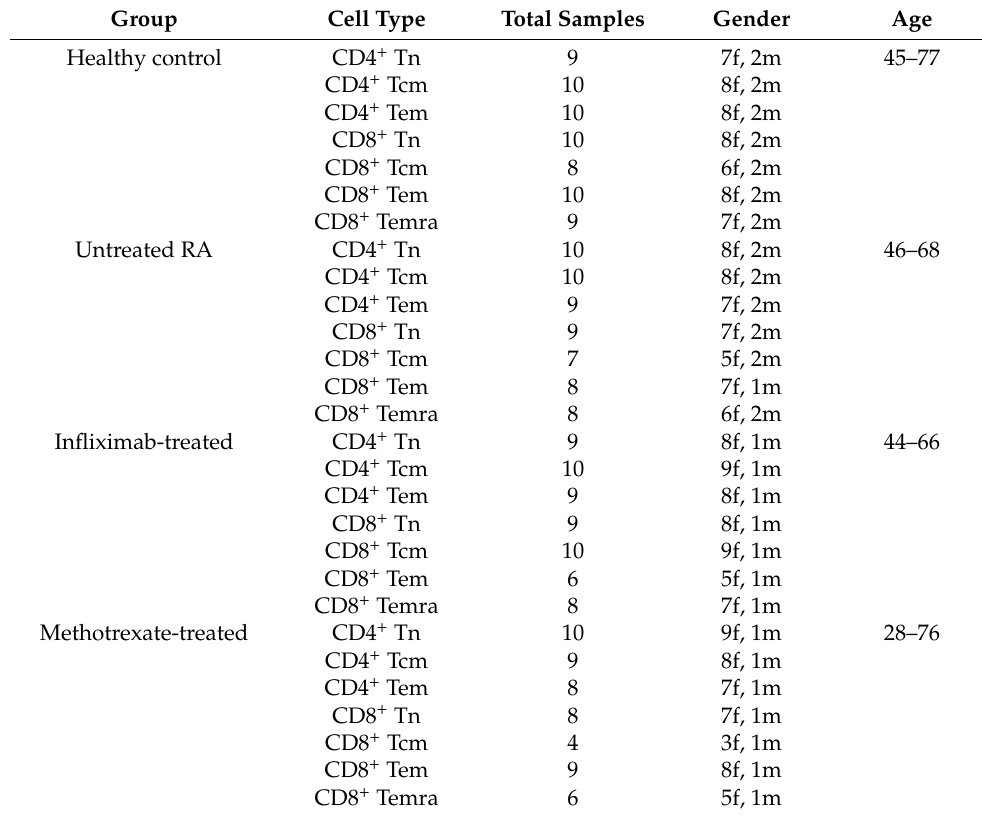
Table 1. Details of the samples in the data set